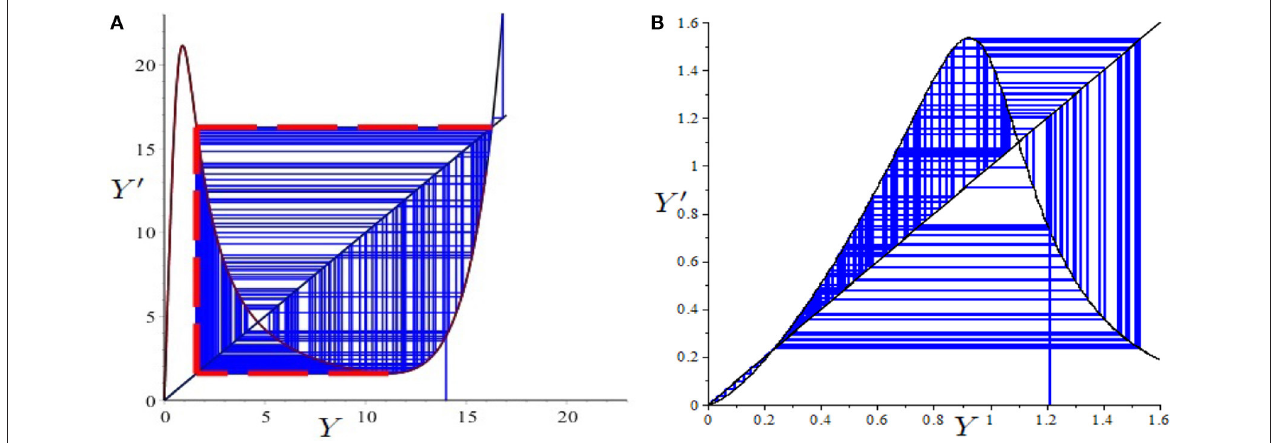
FIGURE 9 | Figure reproduced with the permission of the publisher. Source: Caravaggio and Sodini [14]. (A) Positive divergence when λ < θ ; (B) convergence to a nonproductive state when λ > θ .